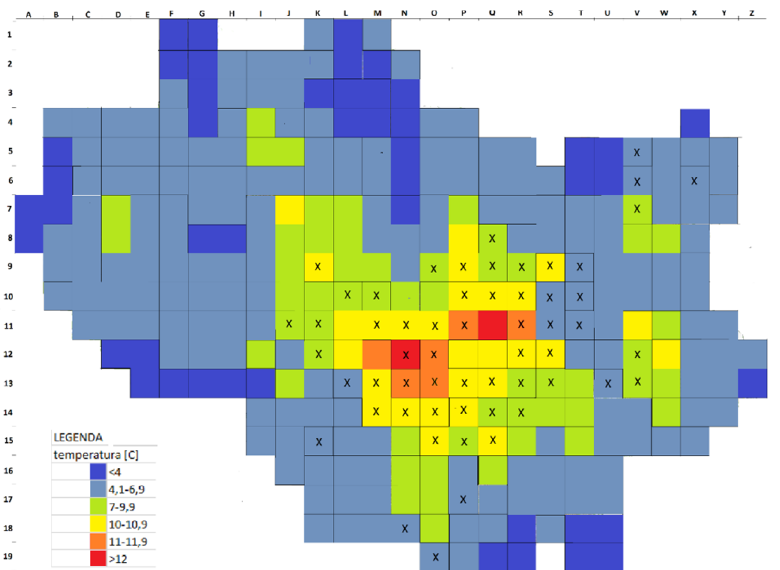
Figure 1. Environmental conditions. The type of development is generalized in a network of squares with an area of 1 square kilometer.